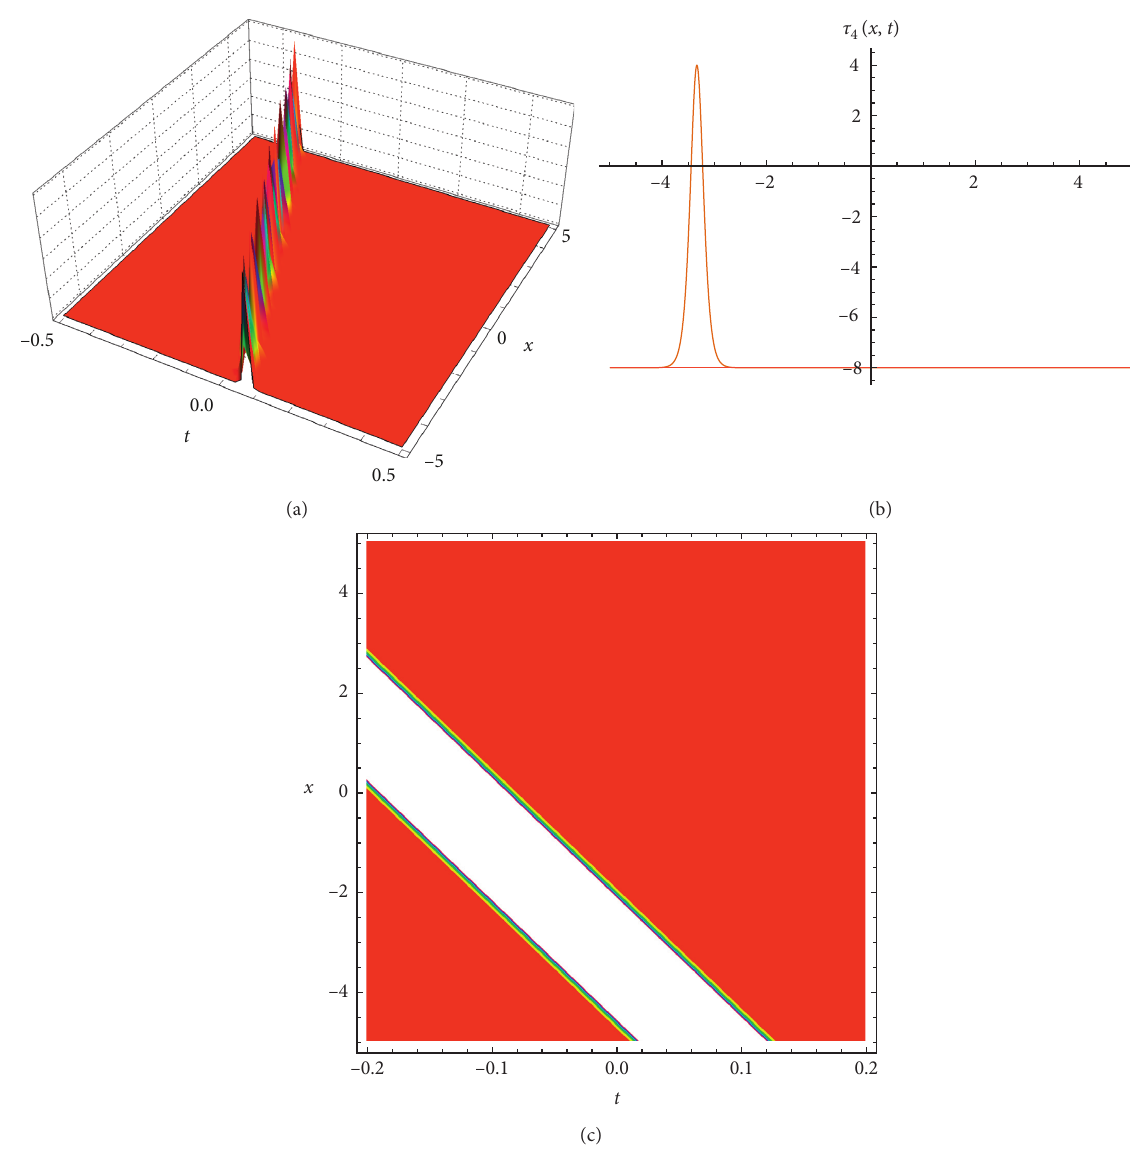
Figure 1: Solitary wave in three different forms of equation